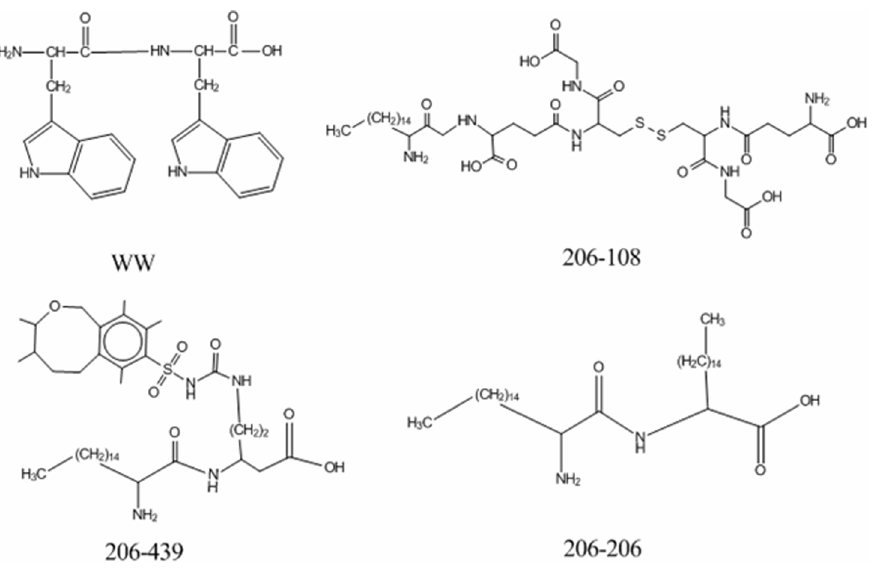
Figure 4. The newly designed peptide mimetics for BTDs. The forty-sixth sample in training set, WW, is regarded as a template to design molecules. The activity of WW, 206-108, 206-439 and 206-206 is 3.60, 9.78, 9.20, and 9.17, respectively.